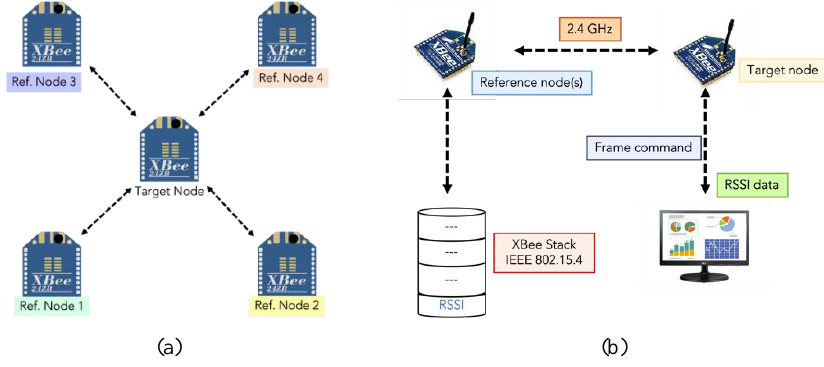
Figure 6. a) Topology star illustration, b) The RSSI acquiring process.